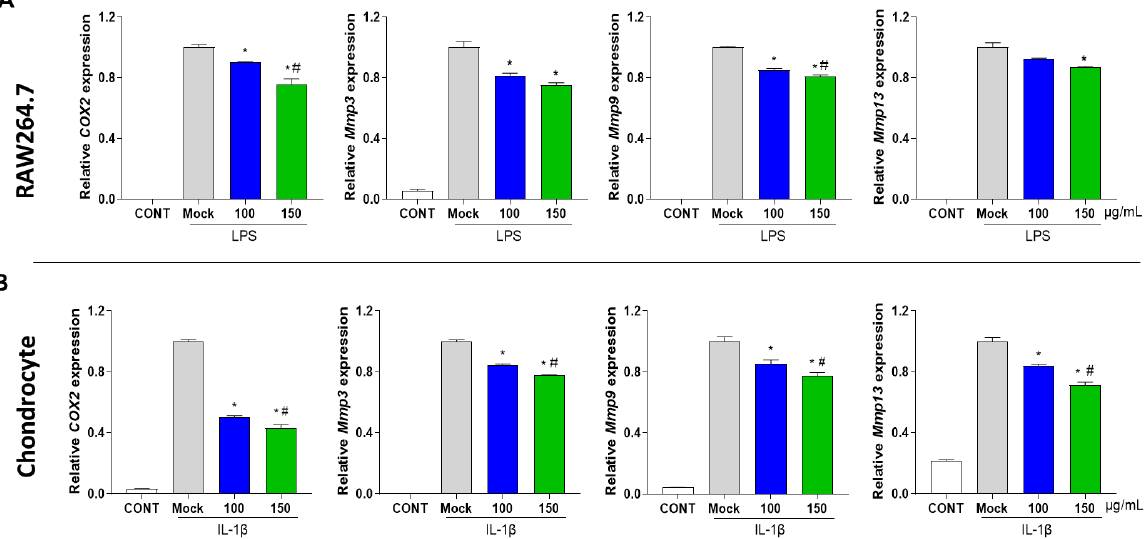
Figure 2. Effect of PG extract on inflammatory-associated factors in RAW 264.7 and primary chondrocytes. ( A ) RAW 264.7 cells were co-incubated with LPS and different concentrations (100 and 150 µ g/mL) of PG extract (8:2 ratio) for 24 h. ( B ) Primary chondrocytes were co-incubated with IL-1 β and different concentrations (100 and 150 µ g/mL) of PG extract (8:2 ratio) for 48 h. Relative expression levels of COX2 , Mmp3 , Mmp9, and Mmp13 were determined by qRT-PCR. * p < 0.05 vs. Mock, # p < 0.05 vs. 100. CONT; non-treated group.